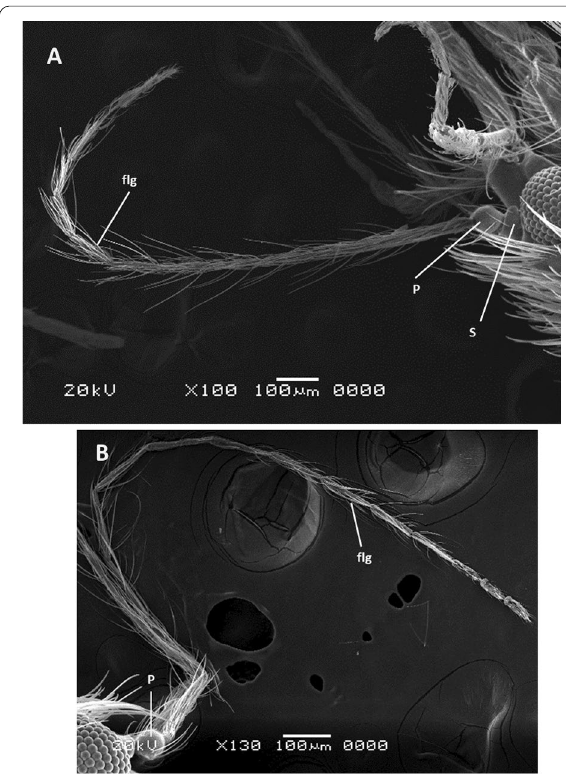
Fig. 1 General morphology of the antennae of Phlebotomus papatasi . A Anterior view of the female antenna. B Anterior view of the male antenna. S: Scape; P: Pedicel; flg: